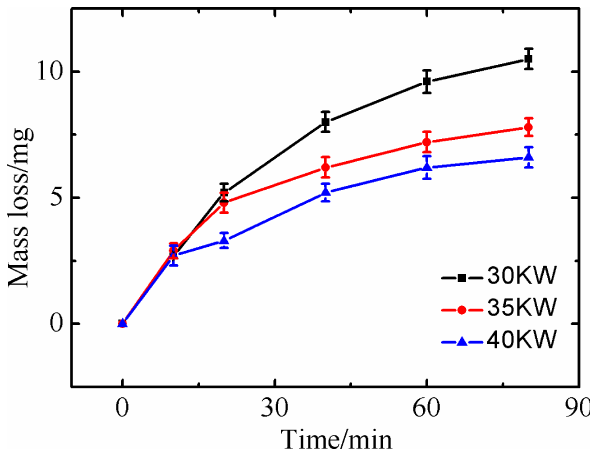
Figure 5: The wear losses of Fe-based amorphous coatings plasma- sprayed under different spraying power